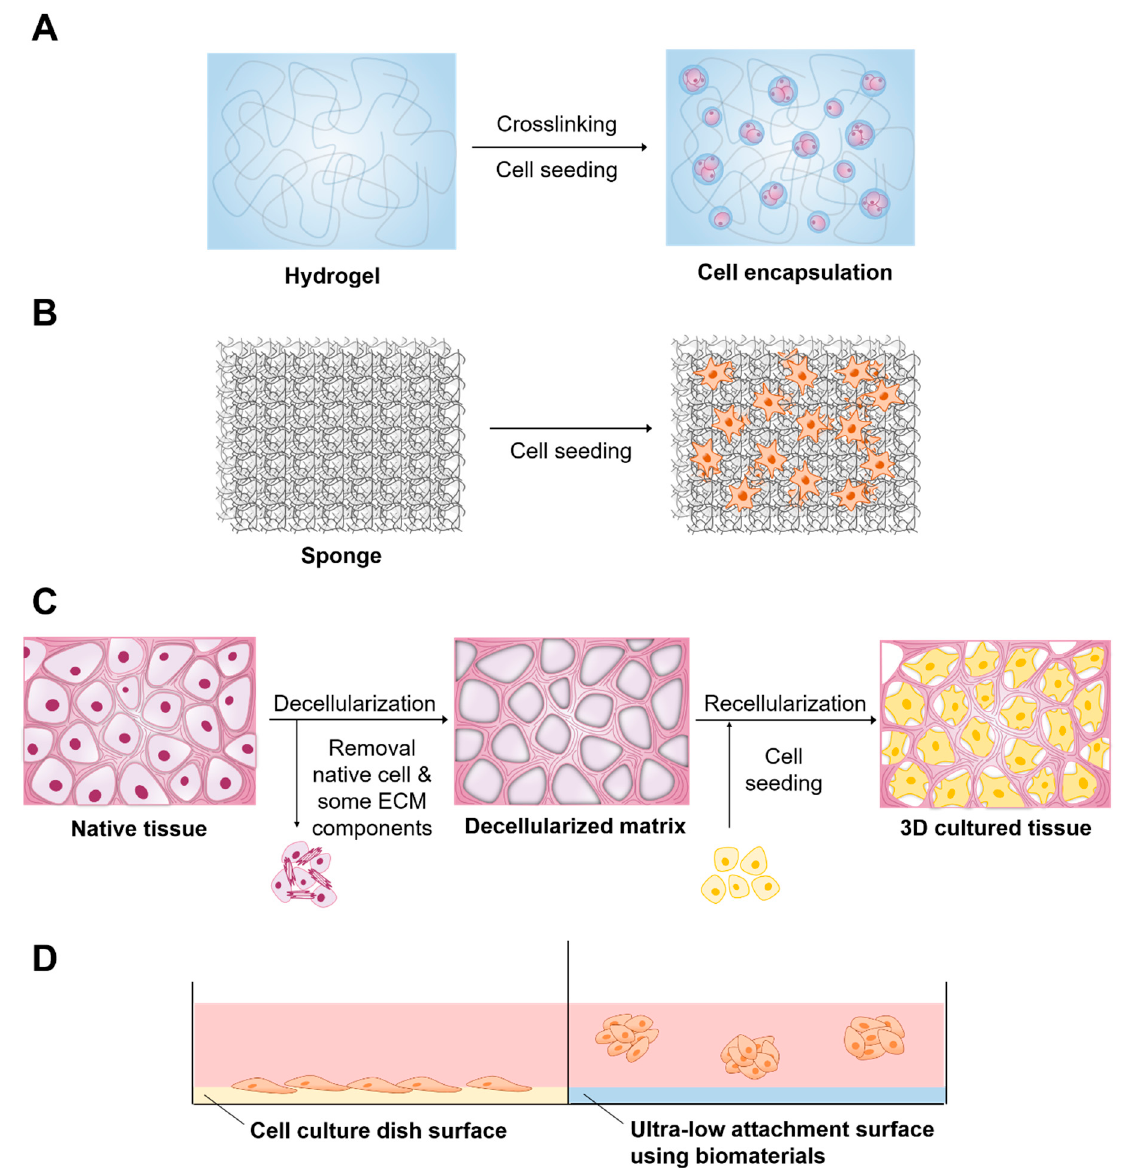
Figure 1. Biomaterials and related method of three-dimensional (3D) cell culture preparation. ( A ) Hydrogel, ( B ) Solid scaffold, ( C ) Decellularized native tissue ( D ) Ultra-low attachment surface.